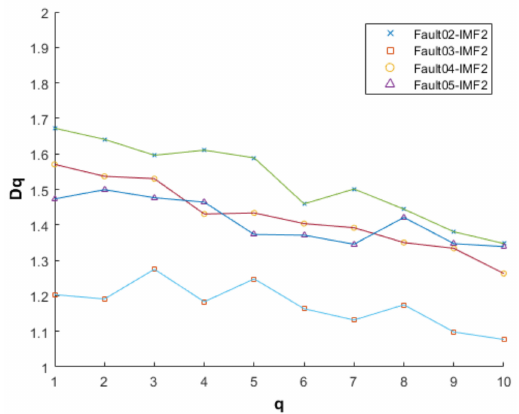
Figure 15. IMF2‑EMD box fractal dimension map.